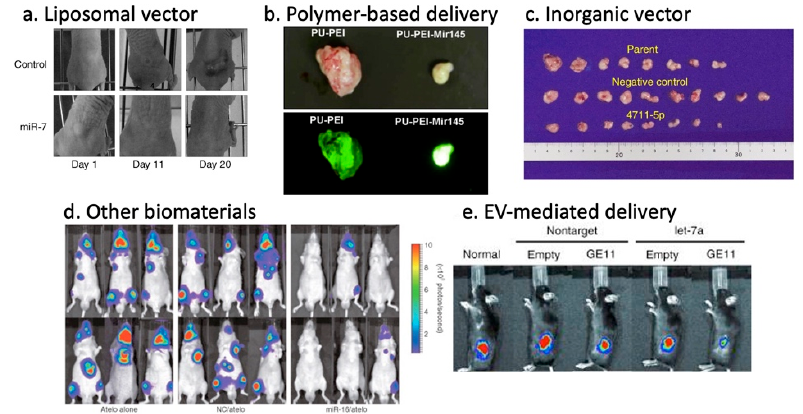
Figure 1. Potent anti-tumor e ff ects of miRNA therapy through various delivery methods. ( a ) Local liposome-miR-7-plasmid treatment of xenograft mice [73]. ( b ) In vivo tumorigenicity assessment of polyurethane-short branch polyethylenimine (PU-PEI)-mediated miR-145 delivery to patient-derived Glioblastoma (GMB) cells [78]. ( c ) Tumor sizes of xenograft mice after systemic super carbonate apatite (sCA)-mediated miR-4711-5p delivery [84]. ( d ) Inhibition of metastatic tumor growth in bone tissues by the atelocollagen-mediated miRNA treatment [93]. ( e ) Inhibition of breast cancer development in vivo using GE11-positive exosomes containing let-7a [91].